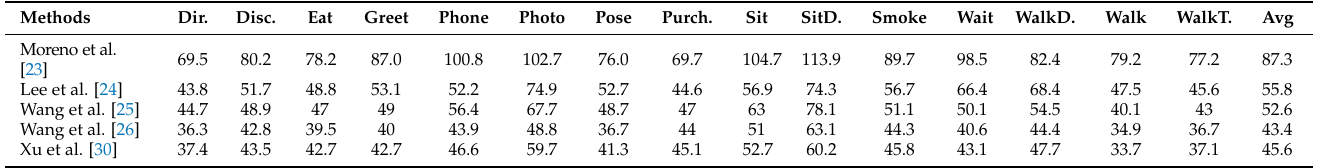
Table 3. Summary of performance on Human3.6 Protocol #1 (MPJPE: